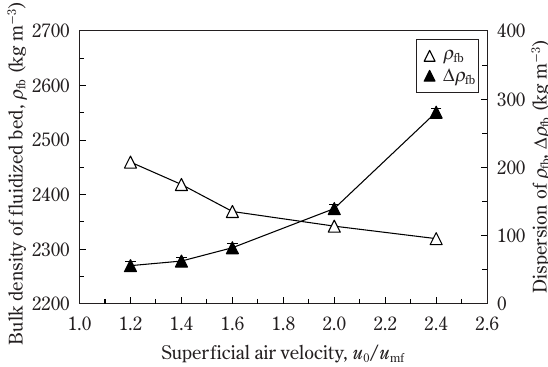
Fig. 5 Dependence of fluidized bed bulk density and its dispersion on superficial air velocity. Powder is uni-beads.